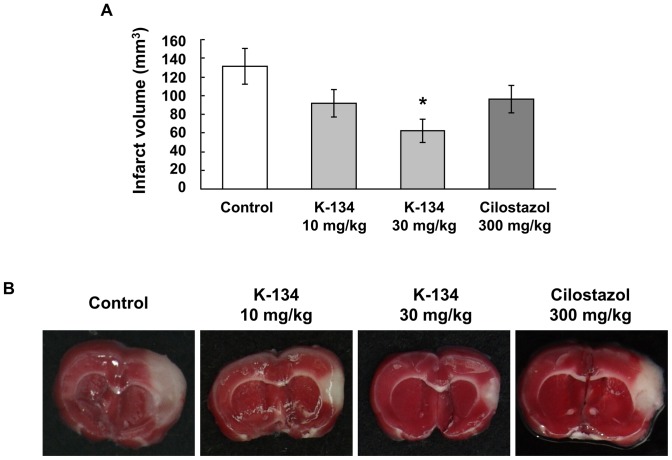
Inhibitory effects of K-134 on infarction volume in a photothrombotic cerebral infarction model.Preadministration of K-134 but not cilostazol significantly and reduced cerebral infarction volume in a photothrombotic cerebral infarction model in comparison with vehicle-treated controls (A). Values are means ± SEM (*P<0.05, two-tailed Dunnett's test, n = 12). (B) Representative photographs (1.35 cm×1.65 cm) show TTC-stained brain sections sliced at the location of bregma. The white-colored area represents the infarct region. Data shown are representative of two experiments with similar results.